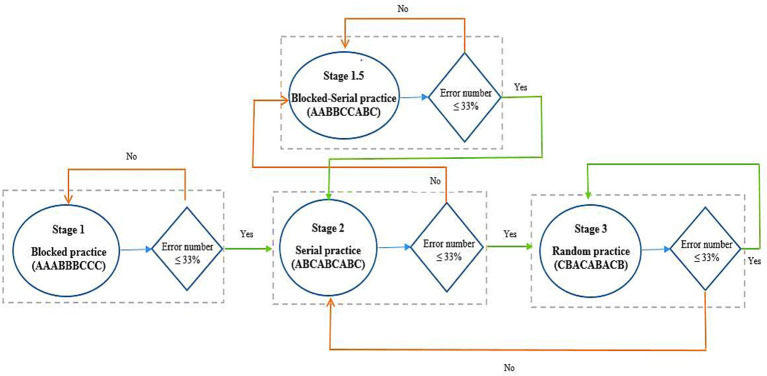
Computer algorithm and how to change the stages in the algorithm practice schedule. Follow the arrows in regards to Yes/No.